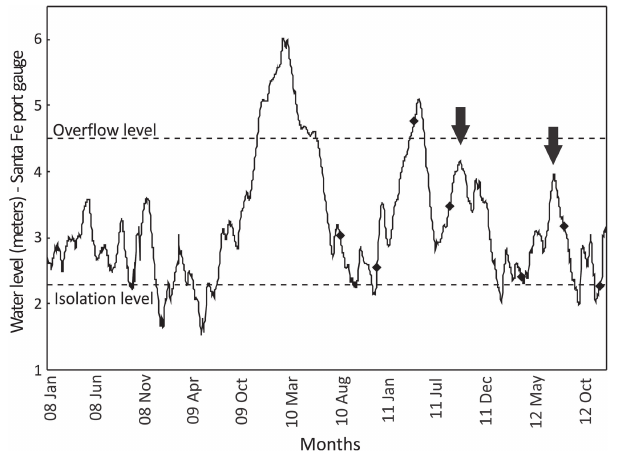
Fig. 3. Daily water levels between January 2008 and December 2012. Full circles: fish samplings. Arrows: 2011 and 2012 flow pulses with hydrometric levels above 3.2 m and below the overflow